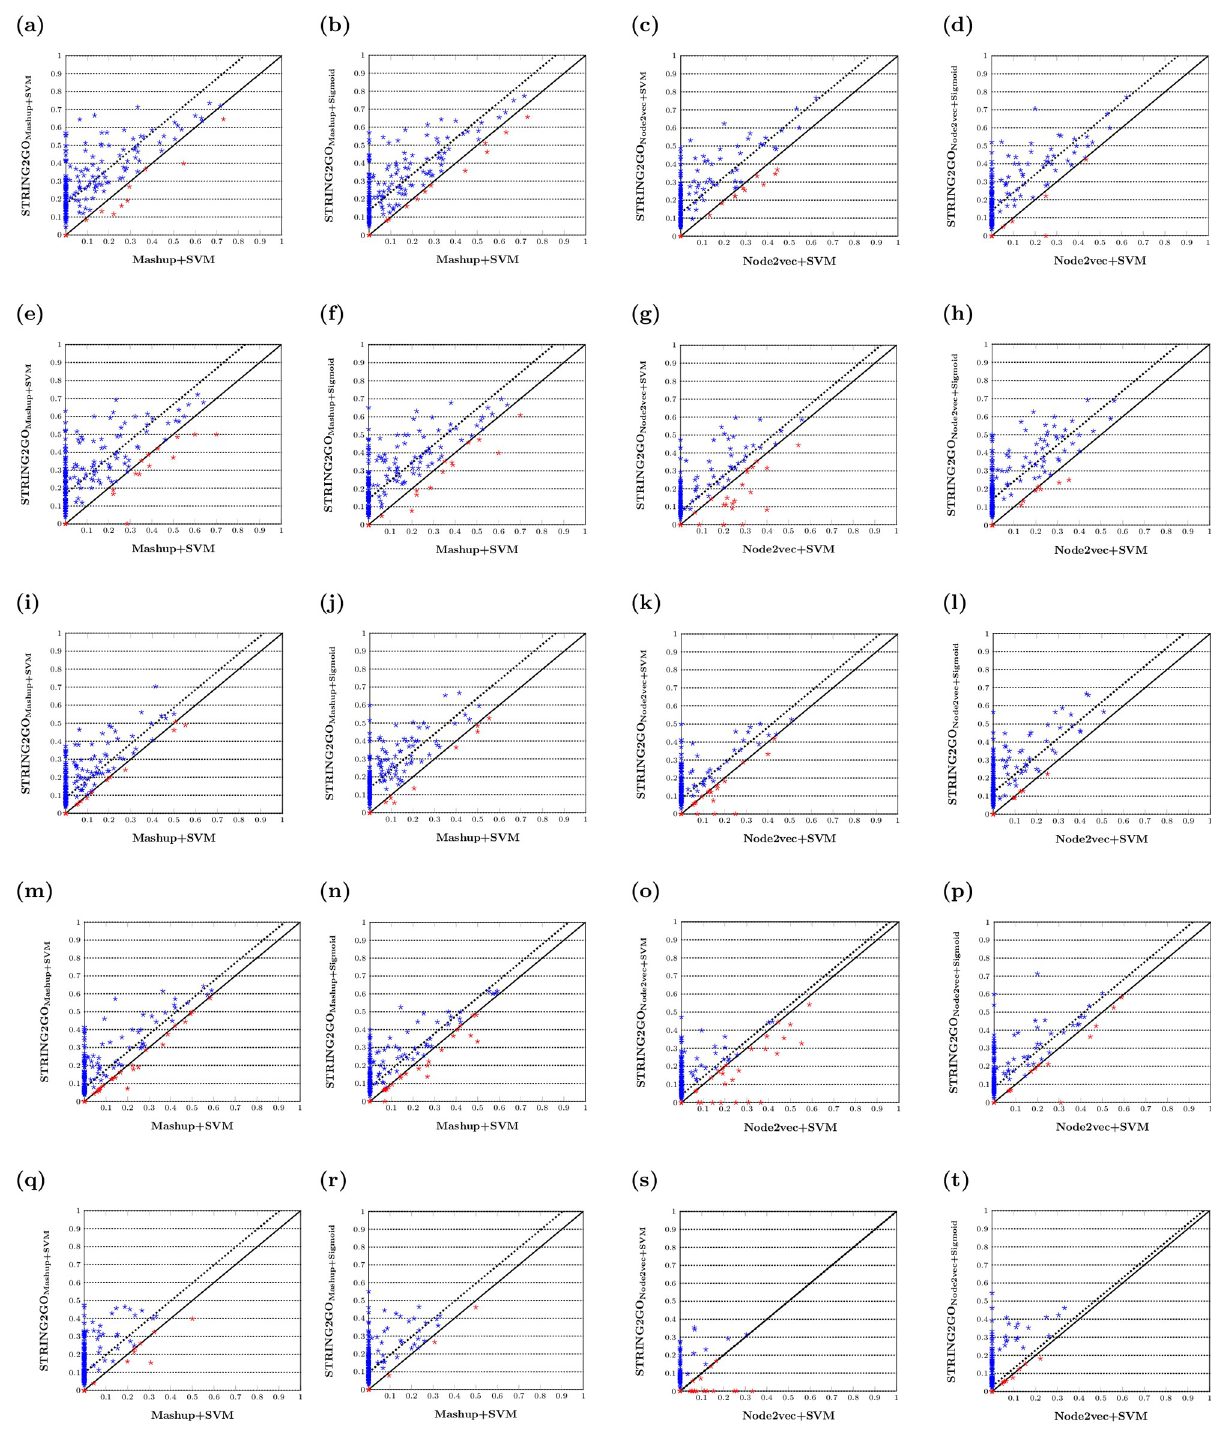
Fig 3. F 1_GO scores obtained by different network embedding representations and the corresponding STRING2GO-learnt functional representations based on (a-d) Combinedscore, (e-h) Textmining, (i-l) Experimental, (m-p) Database and (q-t) Coexpression networks by using SVM or Sigmoid function for